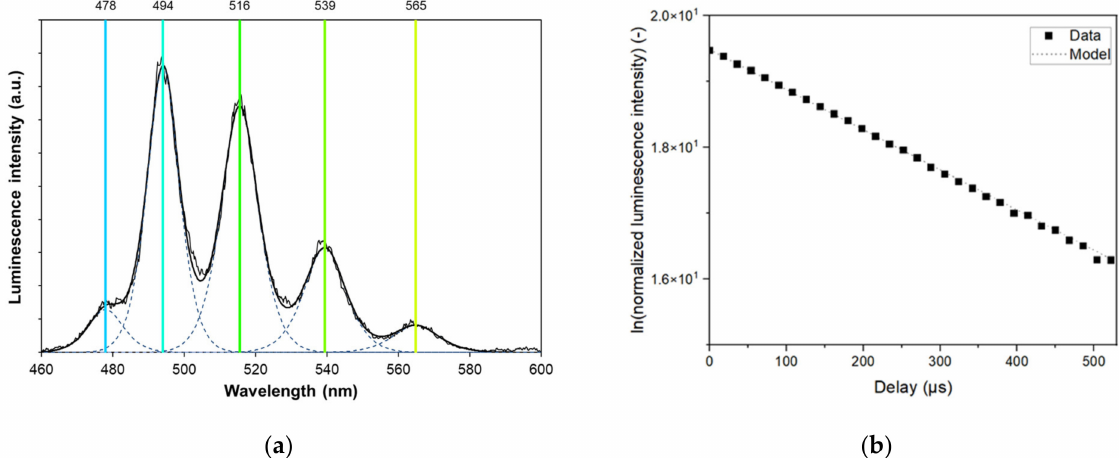
Figure 1. TRLFS results obtained at 22 ◦ C for a solution with an initial U(VI) concentration of 5 × 10 − 6 mol/L in 0.8 mol/kg w H 3 PO 4 : ( a ) U(VI) luminescence spectrum; ( b ) lifetime decay of the resulting U(VI)